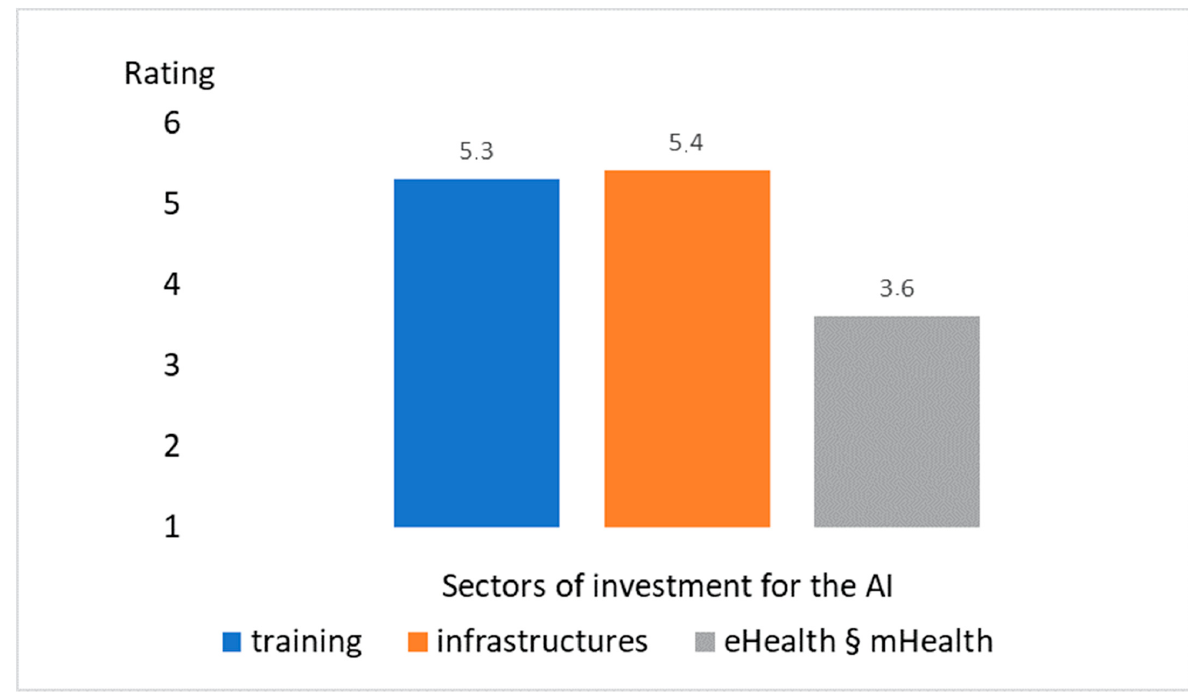
Figure 4. Answers to the Likert scale item #17: “Indicate in which areas of AI application in radiological diagnostics you would invest after the pandemic.”